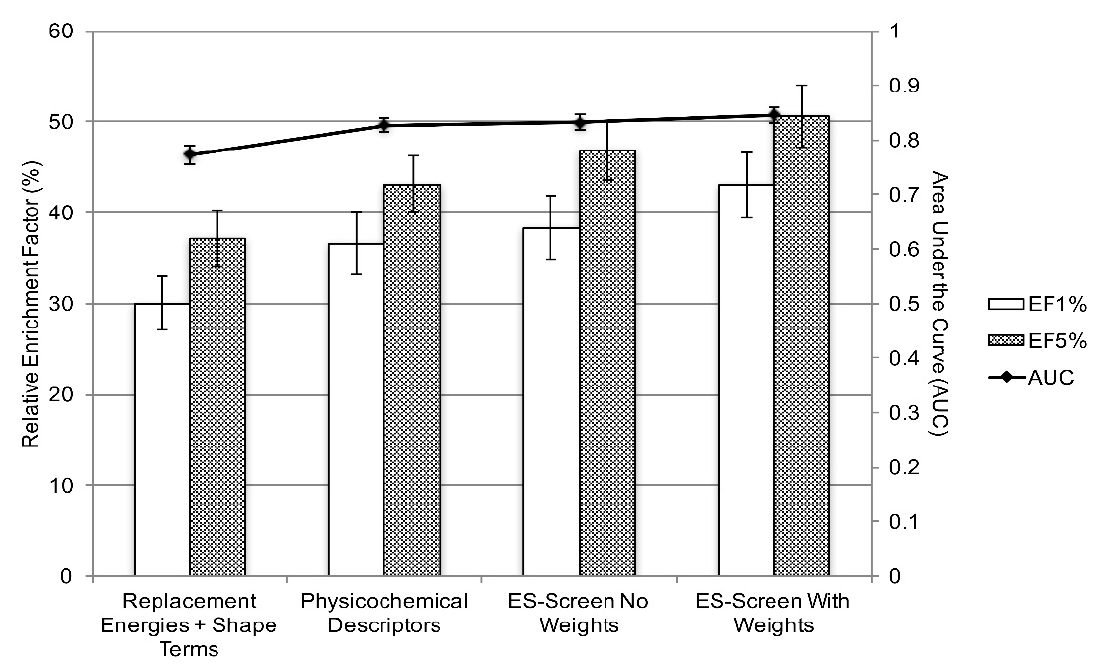
Figure 4. Improvement of virtual screening performance with a combination of parameters and weight adjustment in building ES-Screen. Average performance across N = 53 protein targets using relative enrichment factors EF1% and EF5% and areas under the curve (AUC) derived from ROC curves. Error bars correspond to standard errors of the mean.